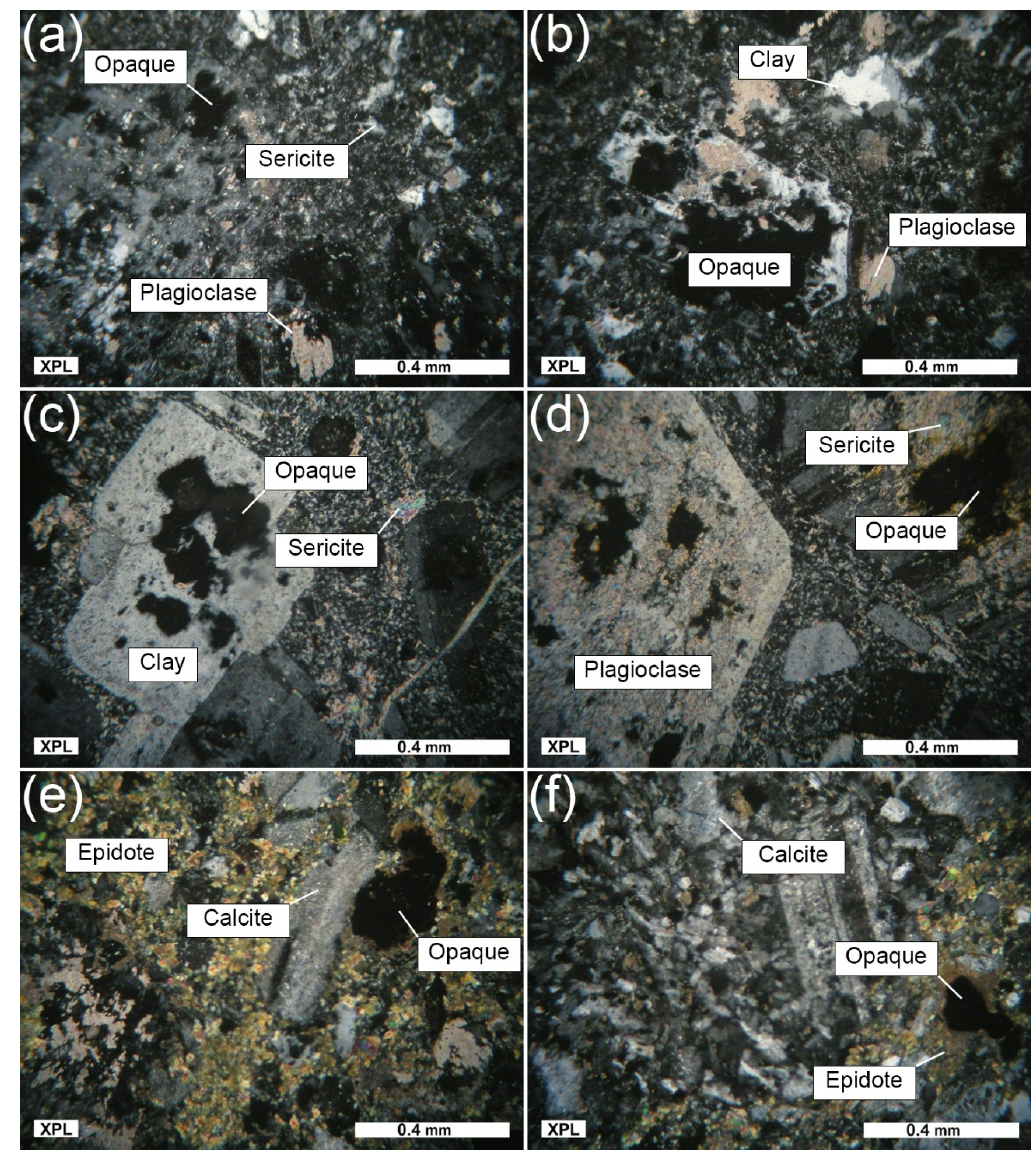
Figure 13. Thin sections of different types of alteration mineralogy. Microphotographs of (a,b) argillic alteration zone—plagioclase replaced with sericite and clay mineral groups; (c,d) phyllic zone—opaque minerals and plagioclase replaced with clay mineral groups and quartz; and (e,f) propylitic zone—completely replaced original mineralogy by calcite, epidote, chlorite, and quartz.